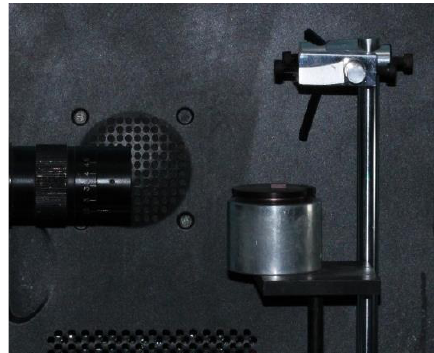
Fig. 1. Contact angle goniometer.